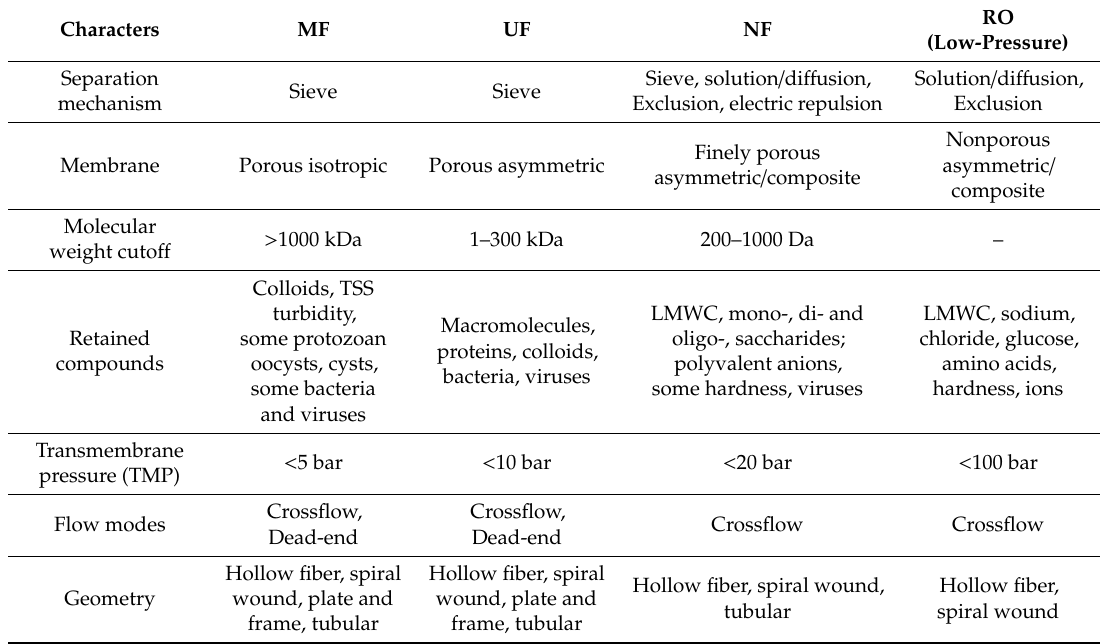
Table 5. Membrane separation characters for water purification